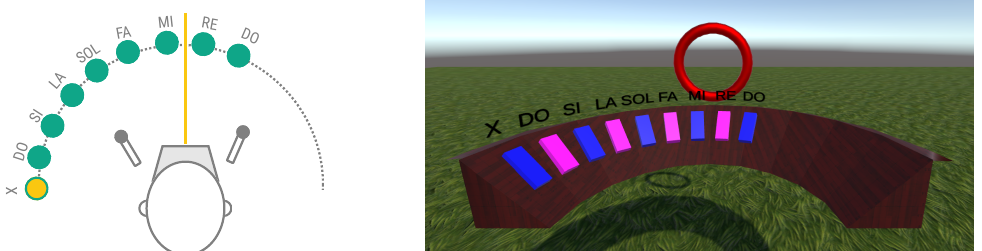
Figure 7. General setup of the asymmetrical setup of the three rehabilitation tasks in schematic ( left ) and virtual environment ( right ).